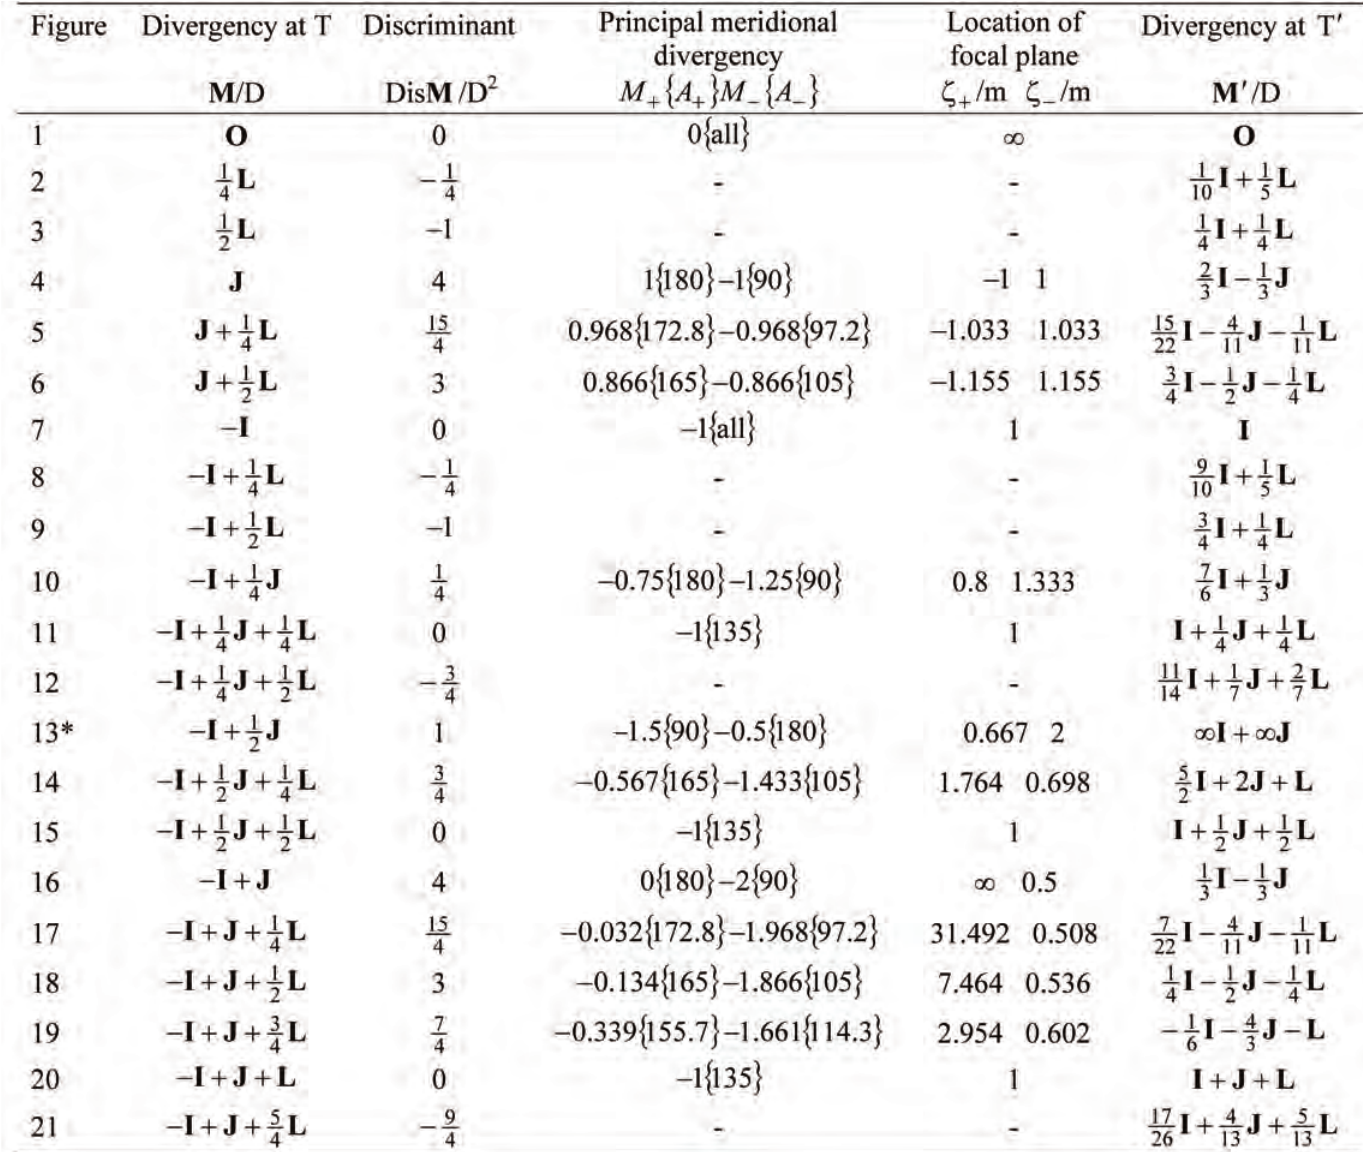
Table 1 The divergency M at entrance plane T, its discriminant (Equation 4), its real principal divergencies M (Equation 5) and principal meridional planes A (Equations 6, 7 or 8), reduced distances to the focal planes ζ (Equation 10) and the divergency M ′ (Equation 2) at exit plane T ′ . Figures 1 and 7 have point foci; in other cases where there is only one focal plane there is a single line focus in the principal meridional plane ( A =φ , Equation 12); where there are two focal planes there is a focal line in each in the complementary principal meridional plane ( ∓ A =φ ± , Equation